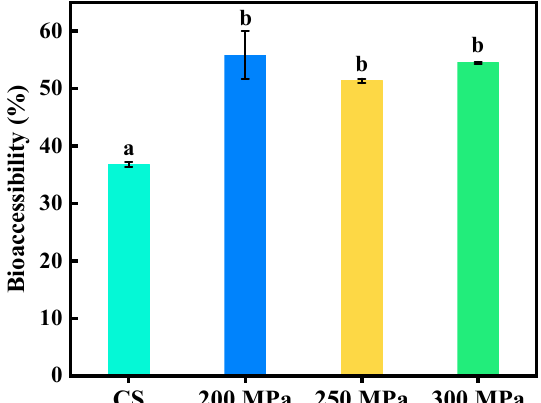
Figure 2. Influence of HPH processing on the polyphenol bioaccessibility of apple juice. Different letters represent the significant difference among means ( p < 0.05).